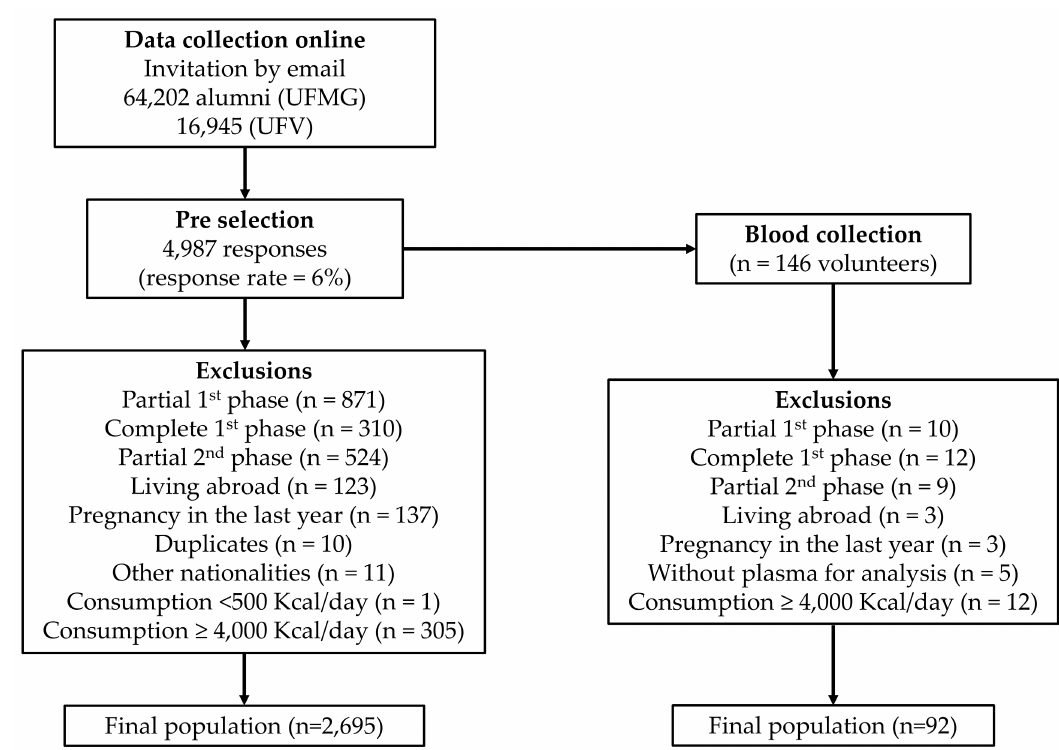
Figure 1. Flowchart of the study ( n = 2,695).